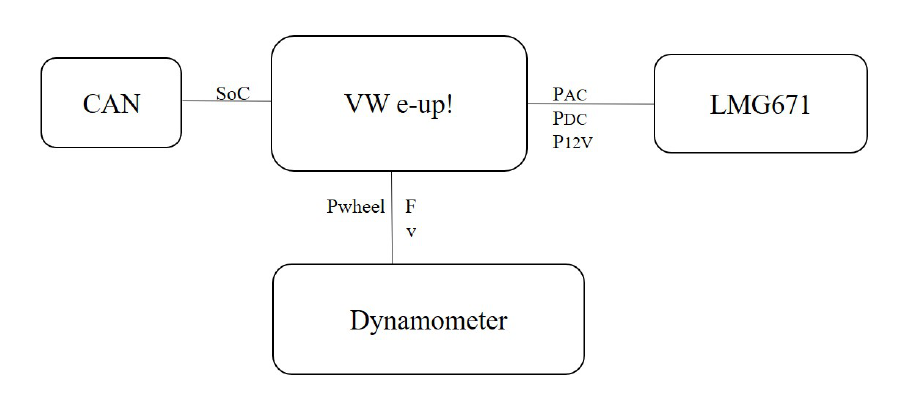
Figure 4. Schematic illustration of the overal measurement setup for